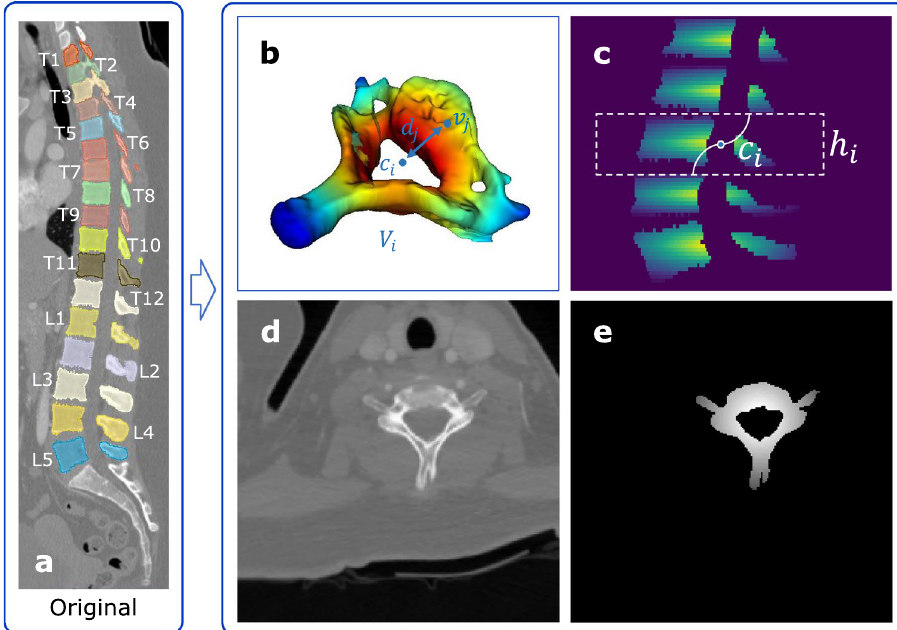
Figure 2. ( a ) The position of each vertebra and its corresponding label of CSI dataset. ( b ) A vertebra with its centroid. ( c ) A partial sagittal dense label of vertebrae centroids. ( d ), ( e ) Transversal slice and its corresponding dense label respectively used as the input and output of